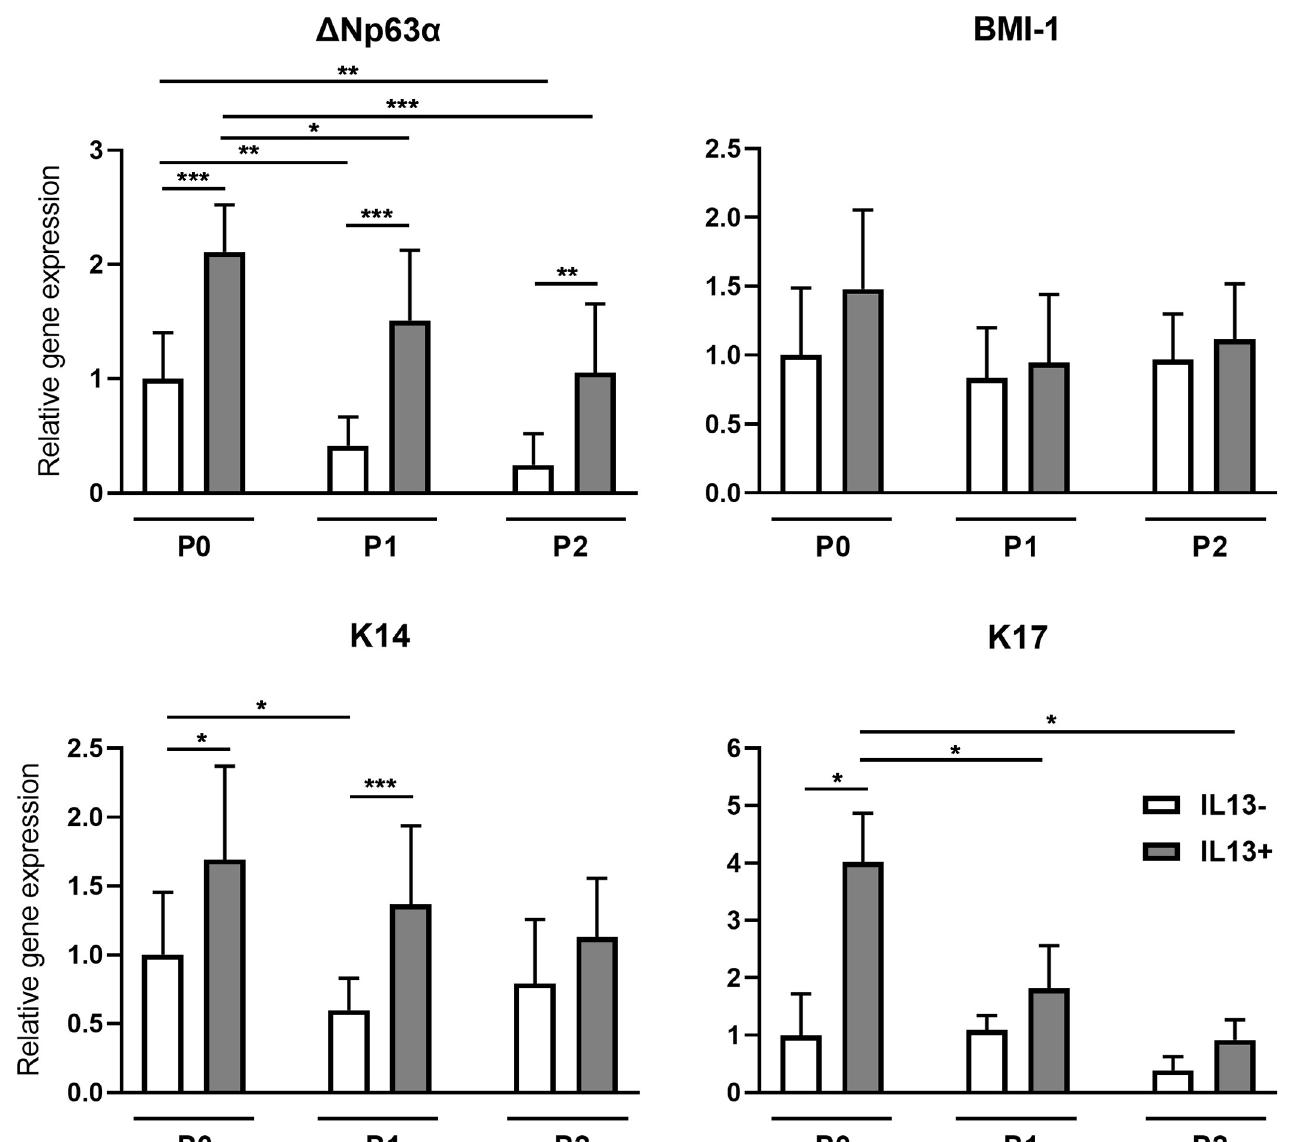
Fig 3. Relative gene expression of Δ Np63 α , BMI-1 , K14 , and K17 in IL13- and IL13+ cell cultures. Cells originating from limbal explants (P0) and passaged cells (P1 and P2) were analyzed at the end of the culture for p63 α , BMI-1 , K14 , and K17 gene expression by qPCR. Each bar represents the mean ± SD of three to ten determinations. The asterisks represent statistically significant difference between the examined groups ( � P < 0.05, �� P � 0.01, ��� P � 0.001).